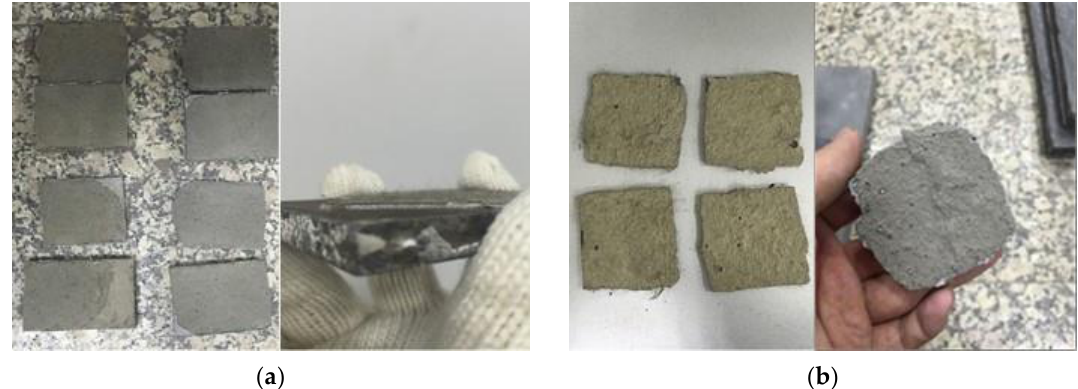
Figure 9. Interfacial failure: ( a ) single shear test and ( b ) pull-off test.